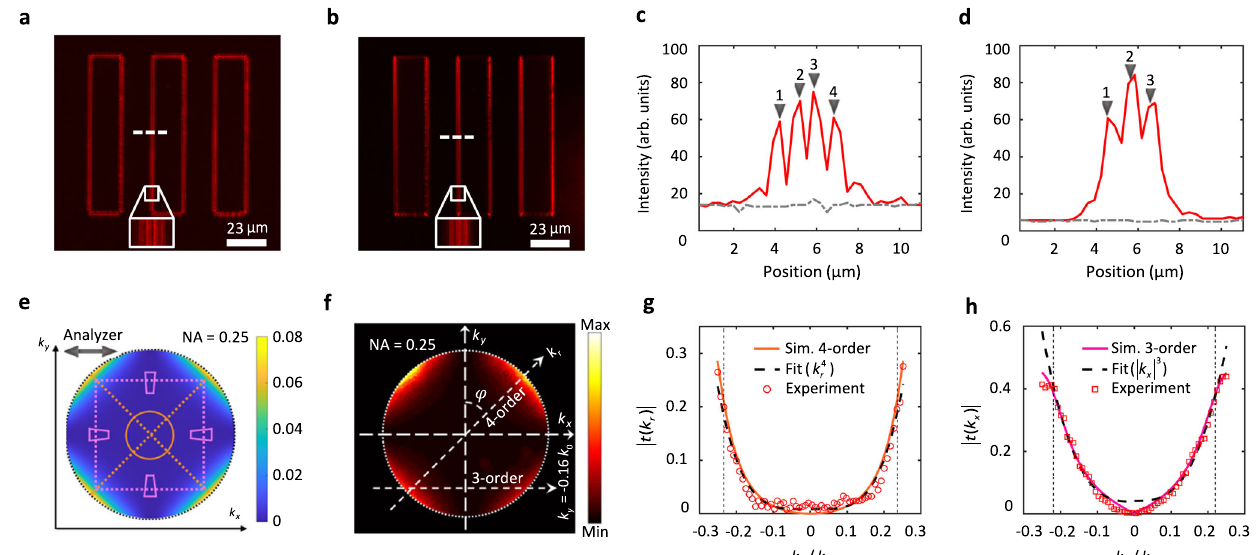
Fig. 4 | The third- and fourth-order spatial differentiation at a wavelength of 638nm.a , b Imagingresultsforthetargetinthecaseofthefourth-order( a )and( b ) the third-order spatial differentiation. The insets in ( a ) and ( b ) show magni fi ed images of the regions marked using a line-box in each case. c , d Intensity pro fi les measuredalongthewhitedashedlinesmarkedin( a )and( b ).Thegreydashedlines represent the background intensity. e Simulated BFP image at λ = 638nm, the doublearrow-headedlineindicatestheorientationoftheanalyzer.Thetrapezoidal regions are designed to perform the third-order differentiation, and the circular